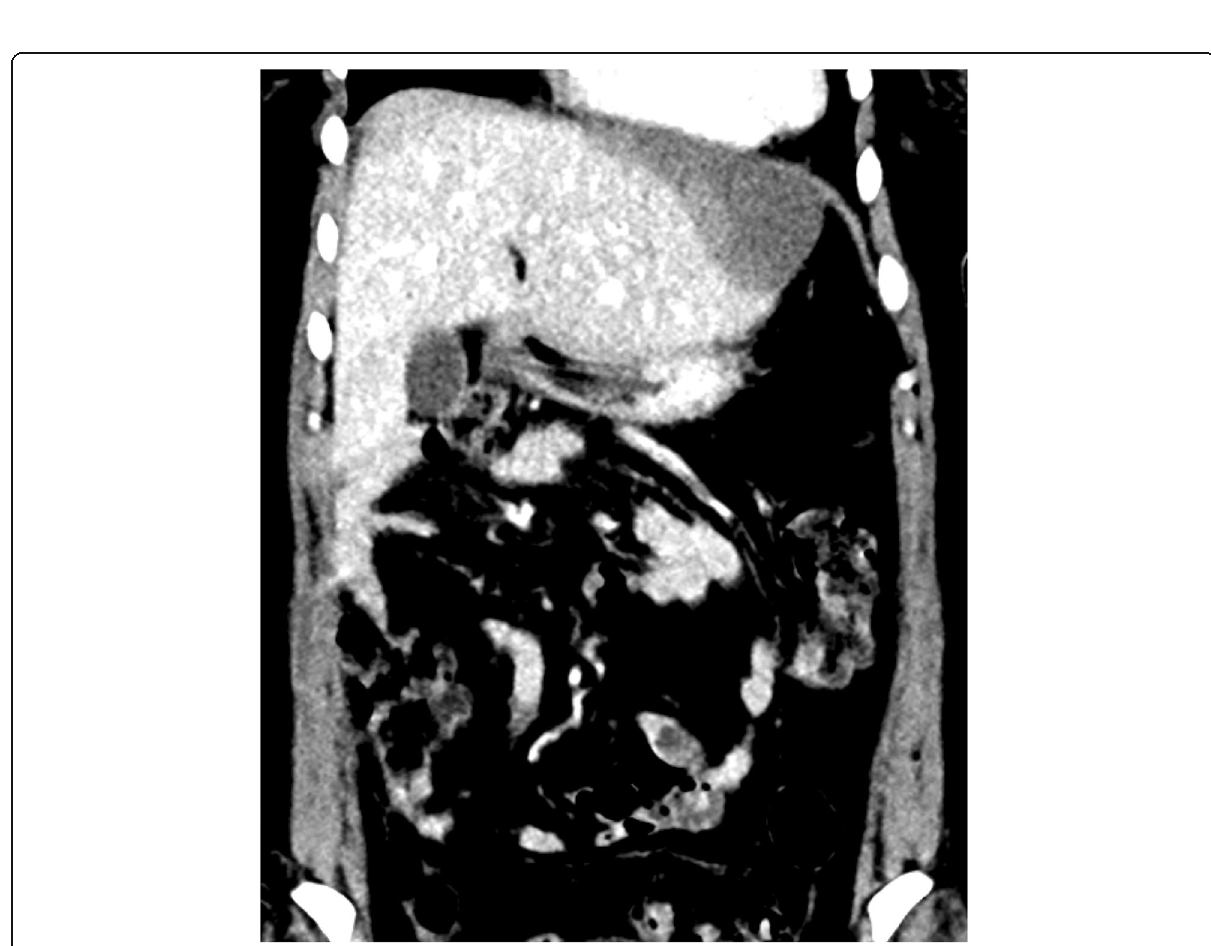
Fig. 2 Initial CT abdomen/pelvis (coronal